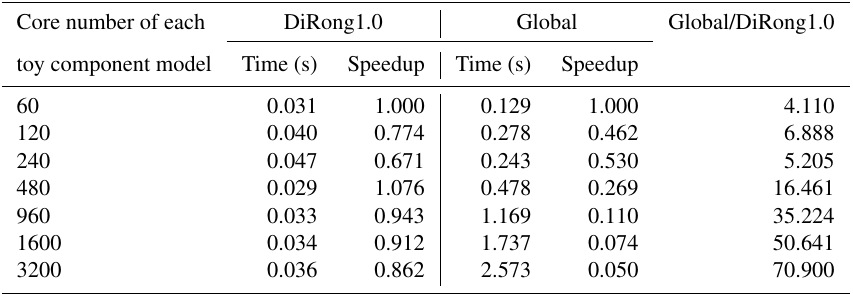
Table 7. Performance of DiRong1.0 and the comparison with the original global routing network generation (Global) using different numbers of cores numbers and the grid size of 500000.